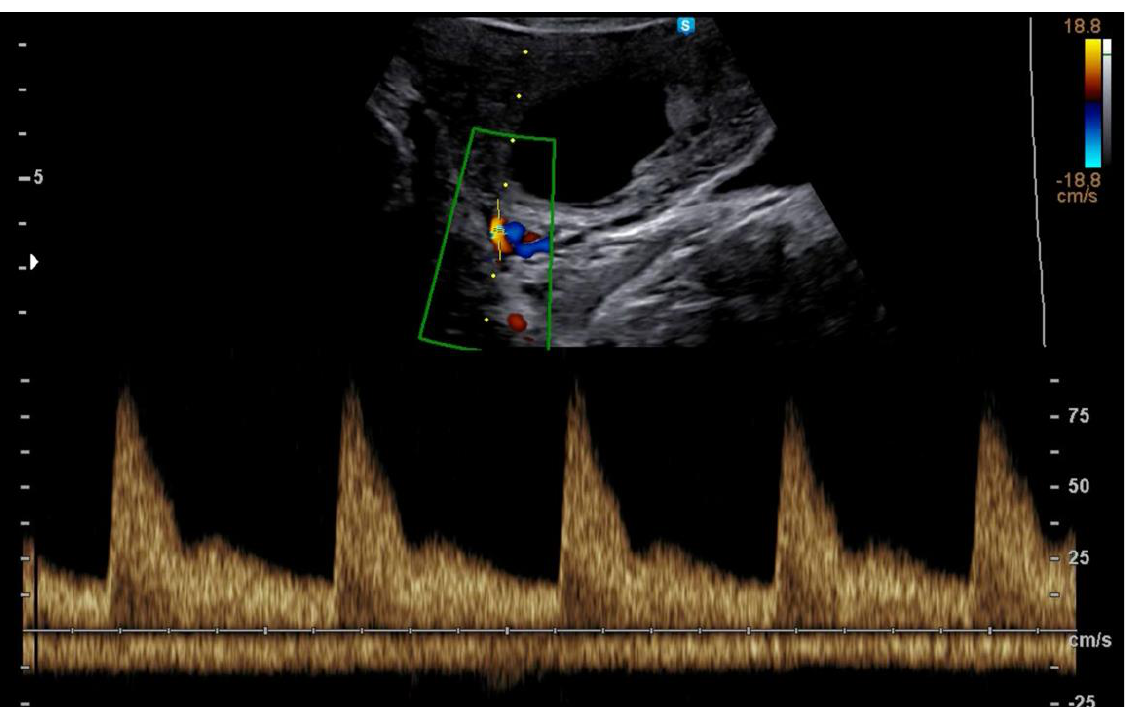
Figure 1. Example of Doppler tracing obtained at 12 weeks from the uterine artery.